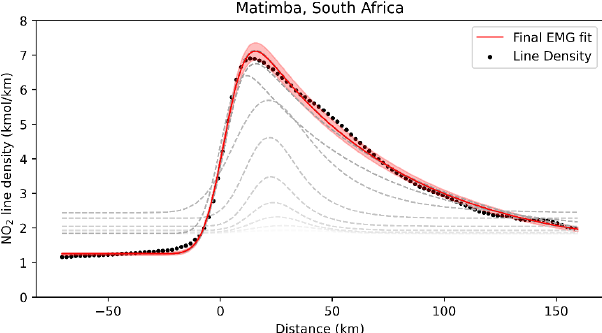
Figure 7. Demonstration of the Curvefit process of fitting the ex- ponentially modified Gaussian (EMG) to the NO 2 line density. The figure was produced using wind-rotated NO 2 from Matimba power station for the period from May 2018 to November 2021. The red line shows the final EMG fit, and the grey lines illustrate the iter- ative fitting procedure (changing from light grey to black as they converge to the final EMG